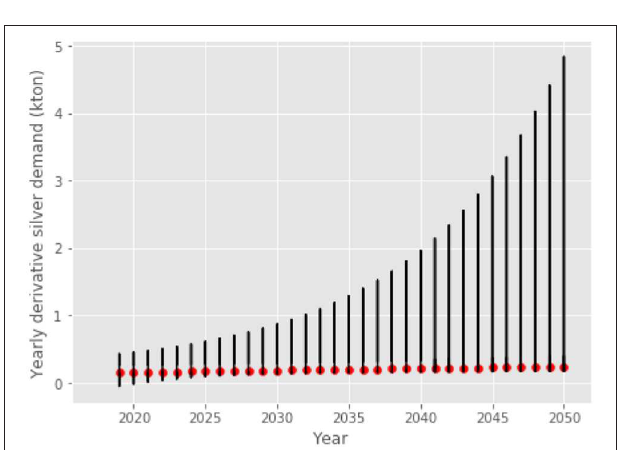
FIGURE 3 | Year-on-year variation of the silver demand (kiloton per year) over 2018–2050 according to the Monte Carlo simulations run on 8,192 quasi-random samples. The means of the yearly distributions are shown in